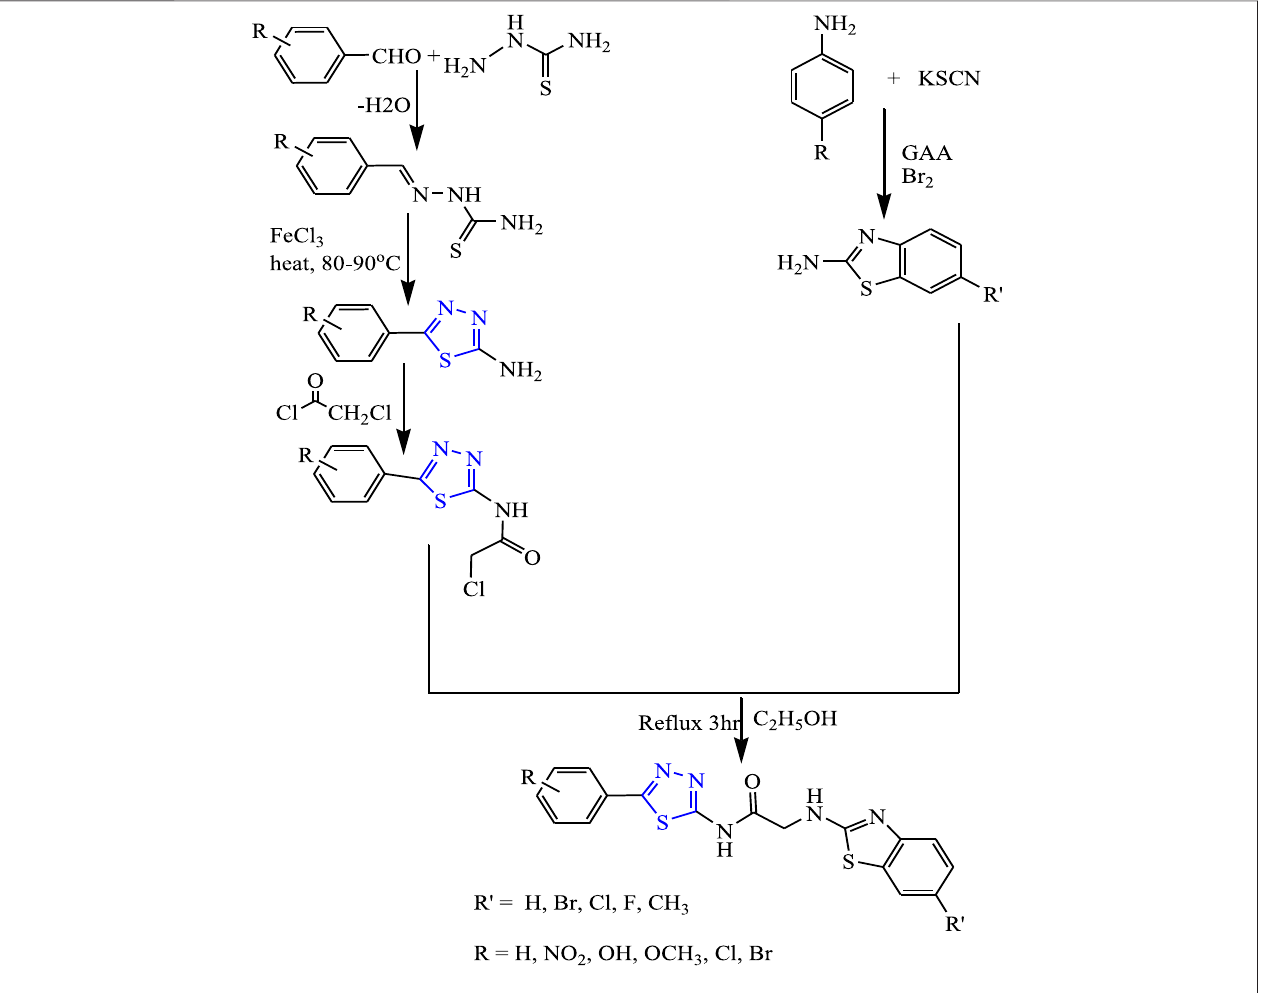
FIGURE 17 | Systematic scheme for synthesizing 1,3,4-thiadiazol-acid-amide derivatives.